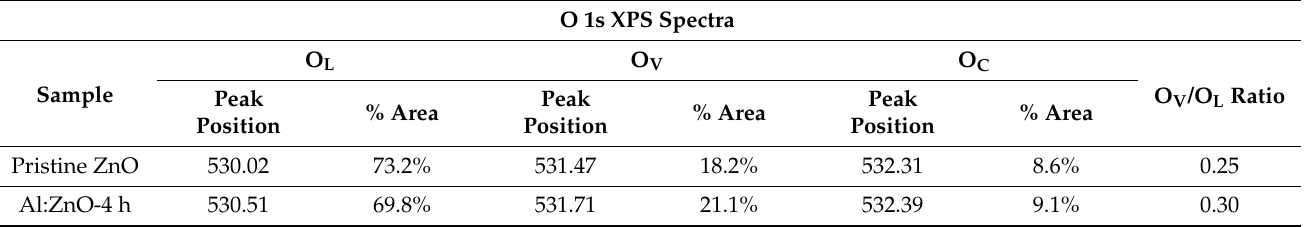
Table 2. The atomic percentage of fitted high-resolution spectra of the O 1s of Al:ZnO-4 h and pristine ZnO